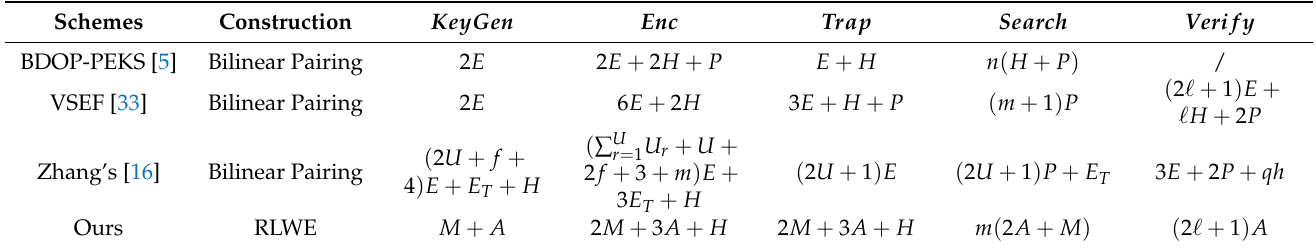
Table 2. Theoretical calculation cost